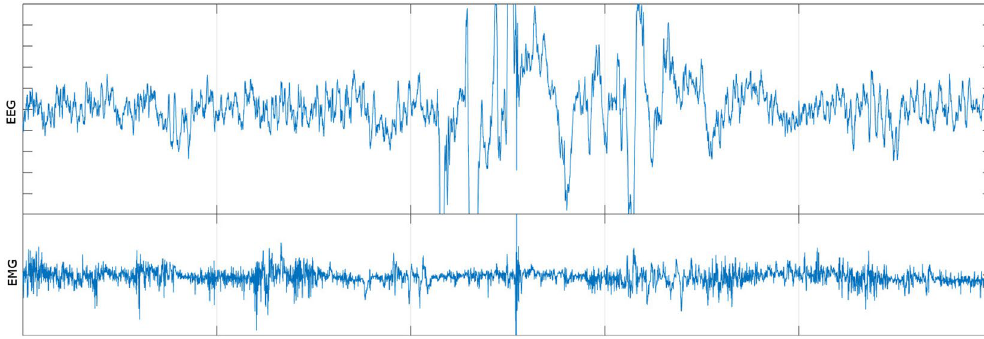
Figure 6. Typical example of noisy signals in large-scale